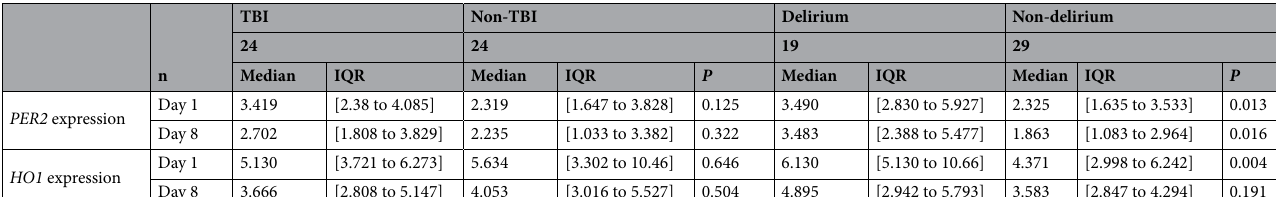
Table 2. Median HO1 and PER2 mRNA expression between groups of TBI/non-TBI and delirium/non- delirium over time. Sample acquisition on first day and after 1 week. P -values of between-group comparisons of PER2 and HO1 mRNA expression (median and IQR) calculated via Mann Whitney test between groups of patients with and without delirium as well as between TBI and non-TBI groups. PER2 period